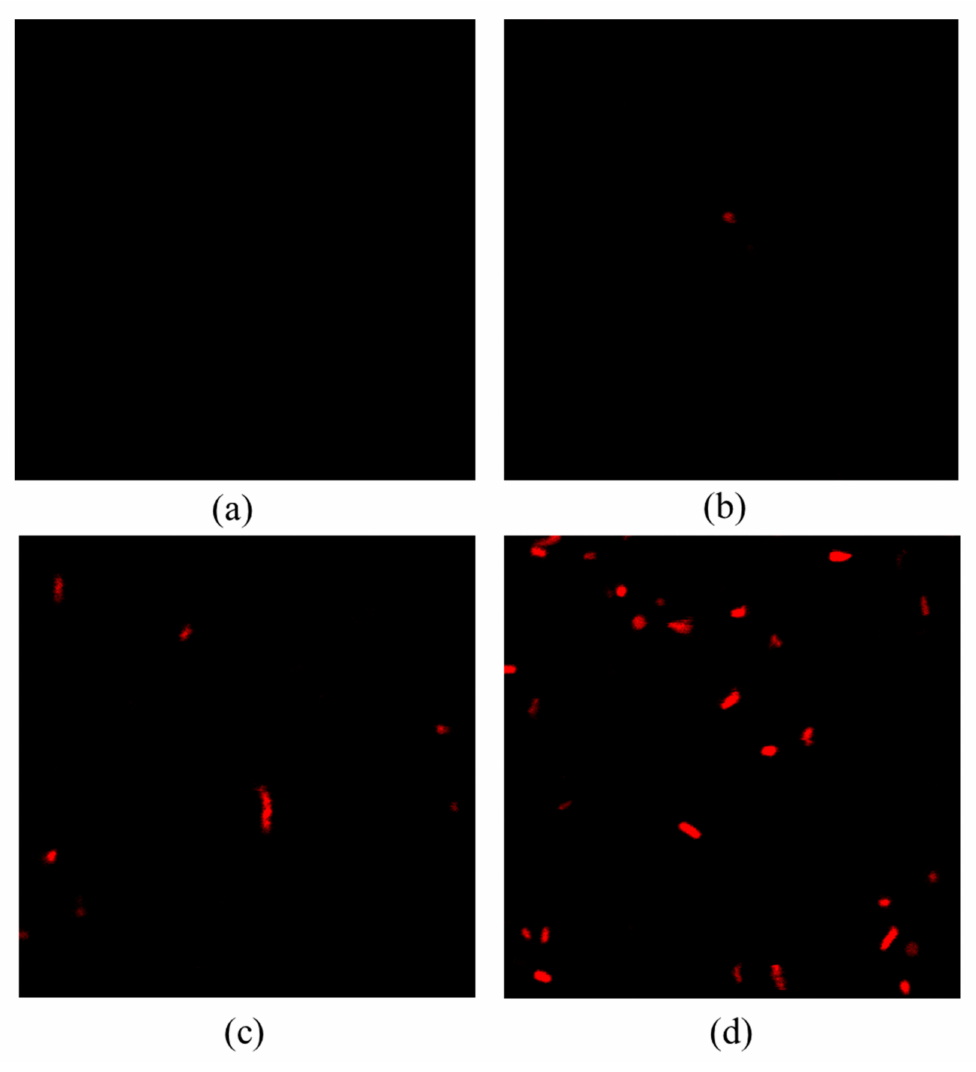
Figure 5. Effect of cold plasma treatment time on the permeability of S. typhimurium . ( a ) Control; ( b ) DBD-treated for 1 min; ( c ) DBD-treated for 3 min; ( d ) DBD-treated for 5